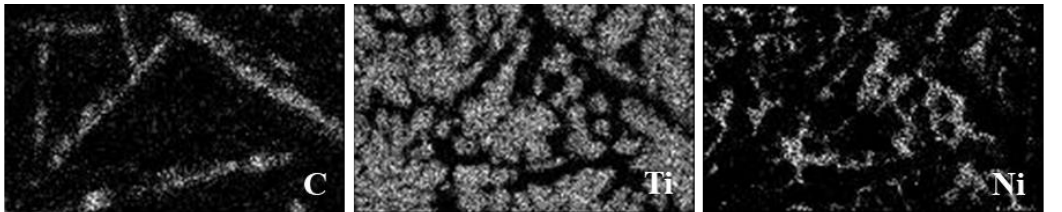
Figure 5. Elemental mapping of the upper layer of the coating for the selected area shown in Figure 3b.